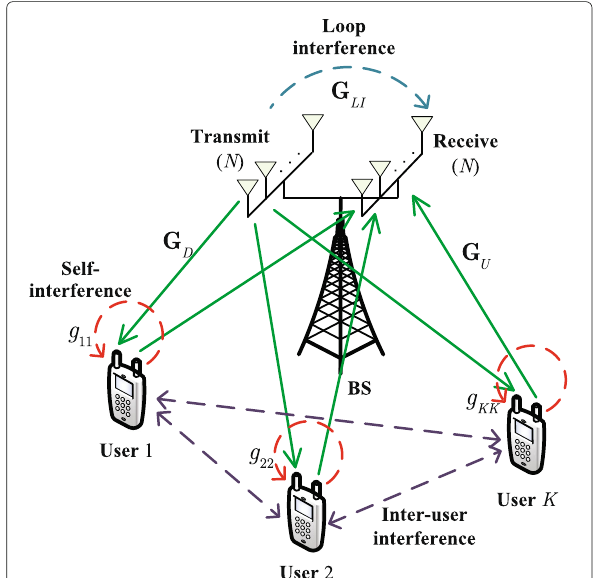
Fig. 1 Multi-user FD massive MIMO system with K